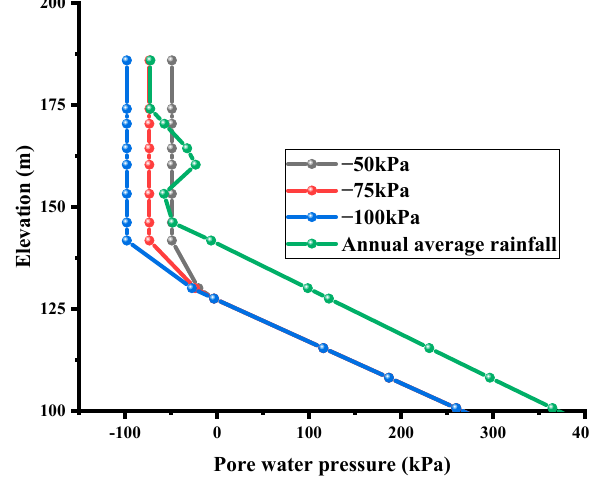
Figure 4. Initial pore pressure distribution.